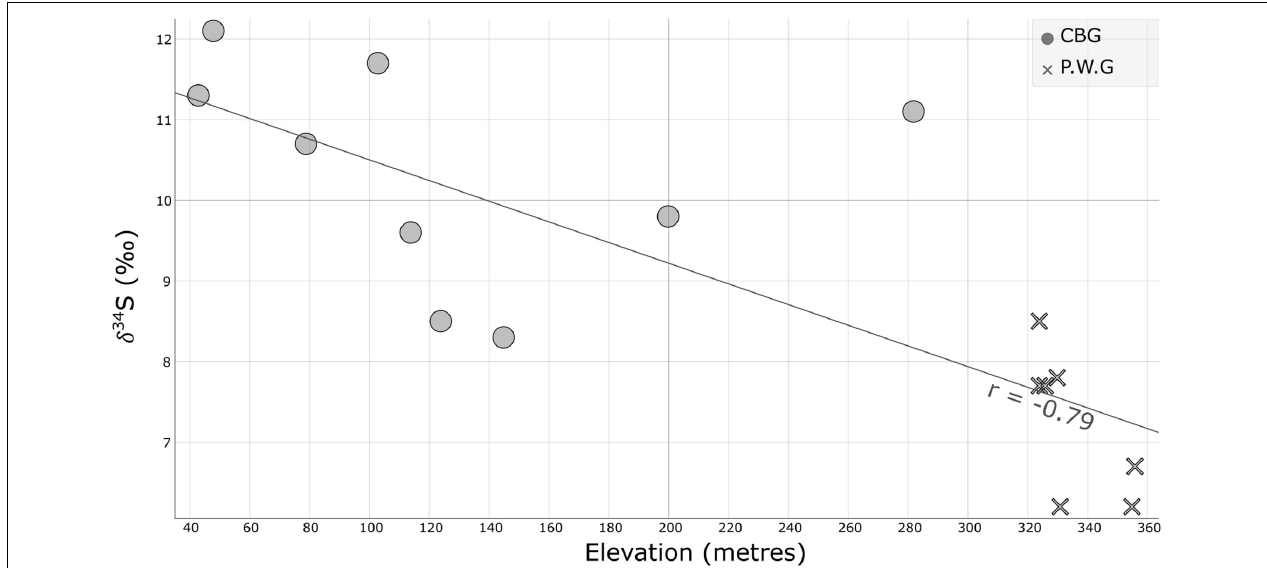
FIGURE 2 | Relationship between elevation and the δ 34 S of Aucoumea klaineana sampled in the P.W.G and C.B.G concessions from